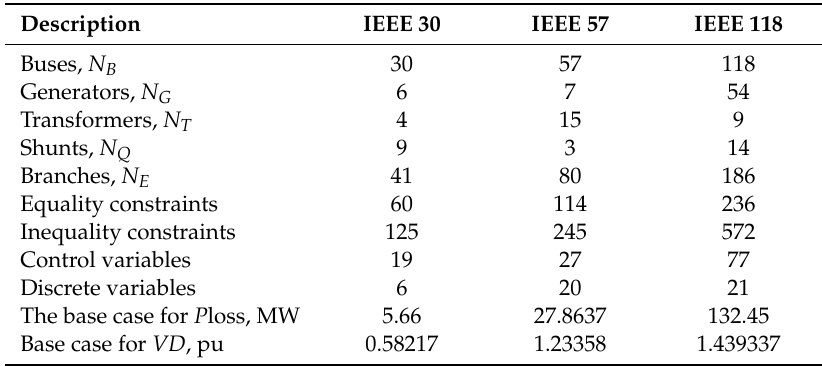
Table 1. The test system’s main